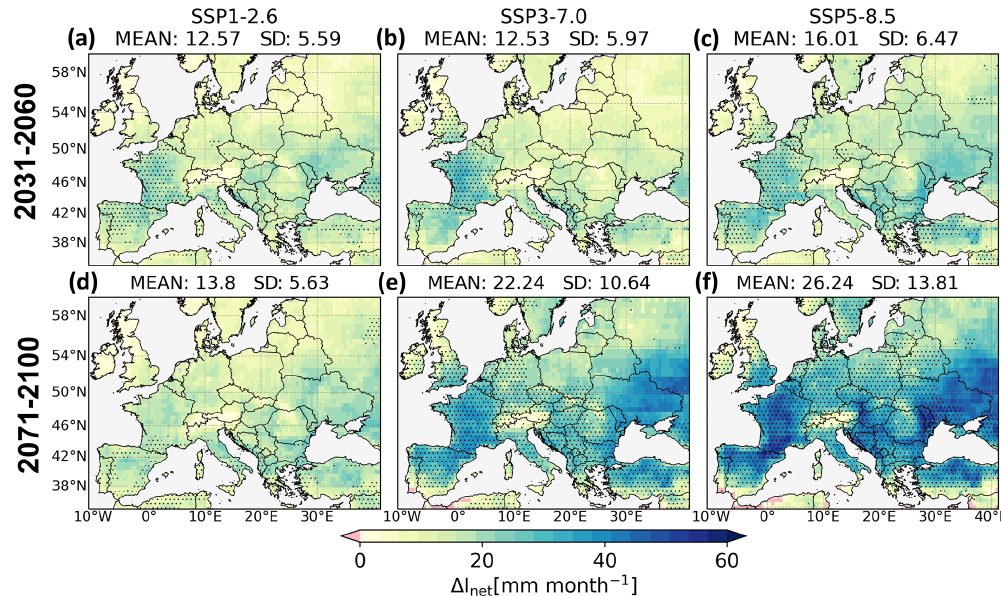
Figure 5. Changes in summer I net ( (cid:49)I net ) (mm per month), median across five GCMs for the two future time horizons (rows) and the three scenarios (columns) with reference to the baseline period. The stippled areas represent pixels where all five GCMs present statistically significant changes ( t test; p < 0 . 05).